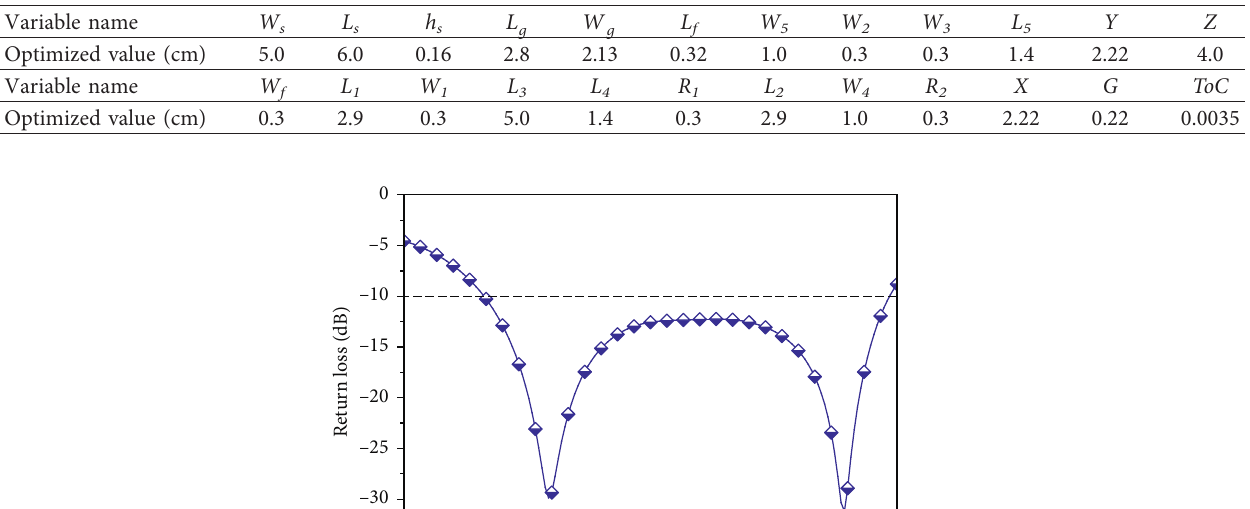
Table 1: Defined variables along with improved values (cm).